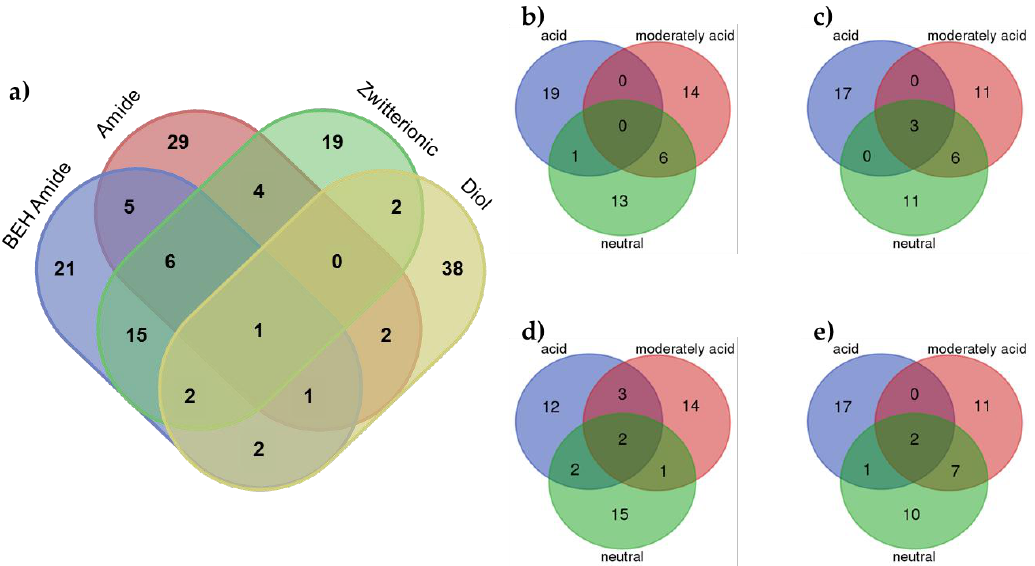
Figure 4. Venn diagrams of the VIPs MDs at ( a ) each stationary phase considering all pH values; ( b ) BEH Amide at each pH condition; ( c ) Amide at each pH condition; ( d ) Zwitterionic at each pH condition and ( e ) Diol at each pH condition.